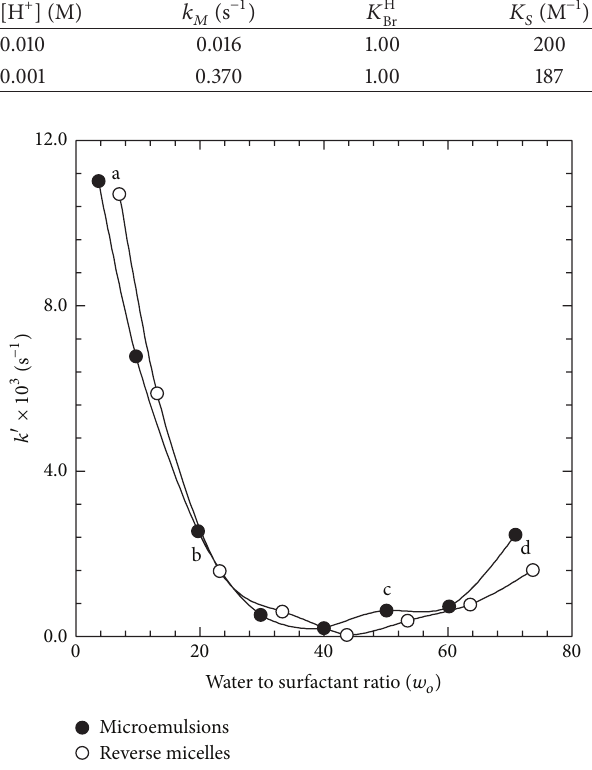
Table 1: The optimized values of 𝑘 𝑀 , 𝐾 𝑆 , and 𝐾 H